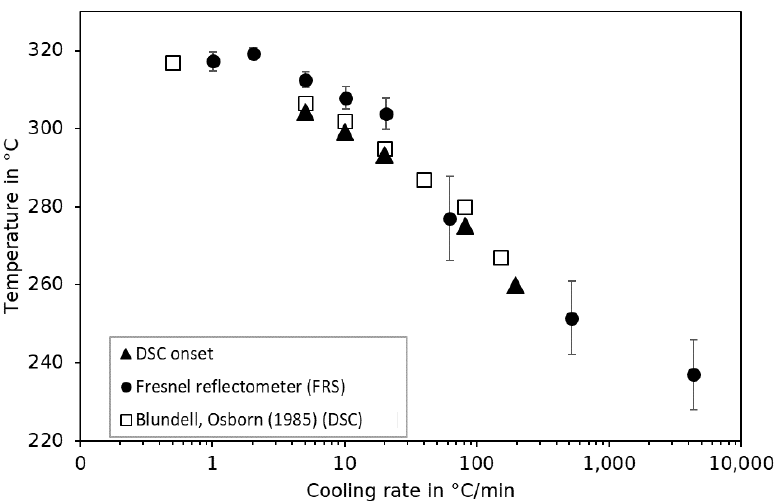
Figure 10. Influence of the crystallization temperature on the cooling rate derived from the DSC and FRS and from the work of Blundell and Osborn (1985)